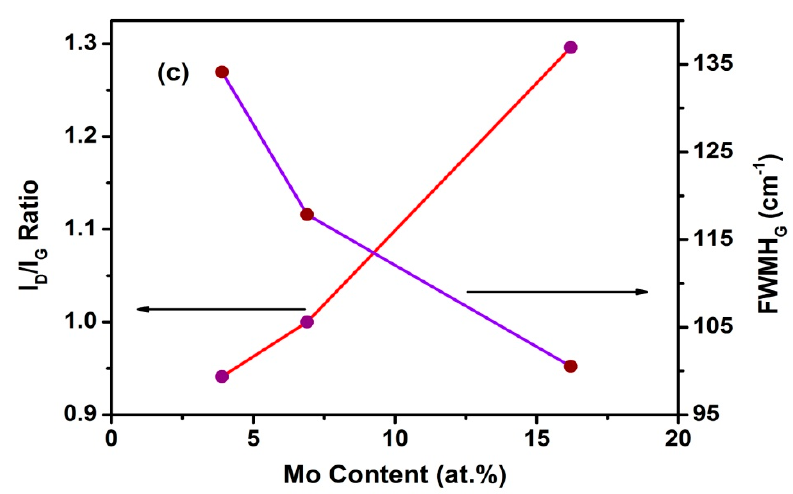
Figure 9. ( a ) Raman spectra of Mo-DLC coatings for different Mo contents ( b ) Gaussian fitting of Raman spectrum of 3.9 at.% Mo-DLC coating, and ( c ) corresponding I D /I G and FWHM of G peak evolution with different Mo concentrations in Mo-DLC coatings.